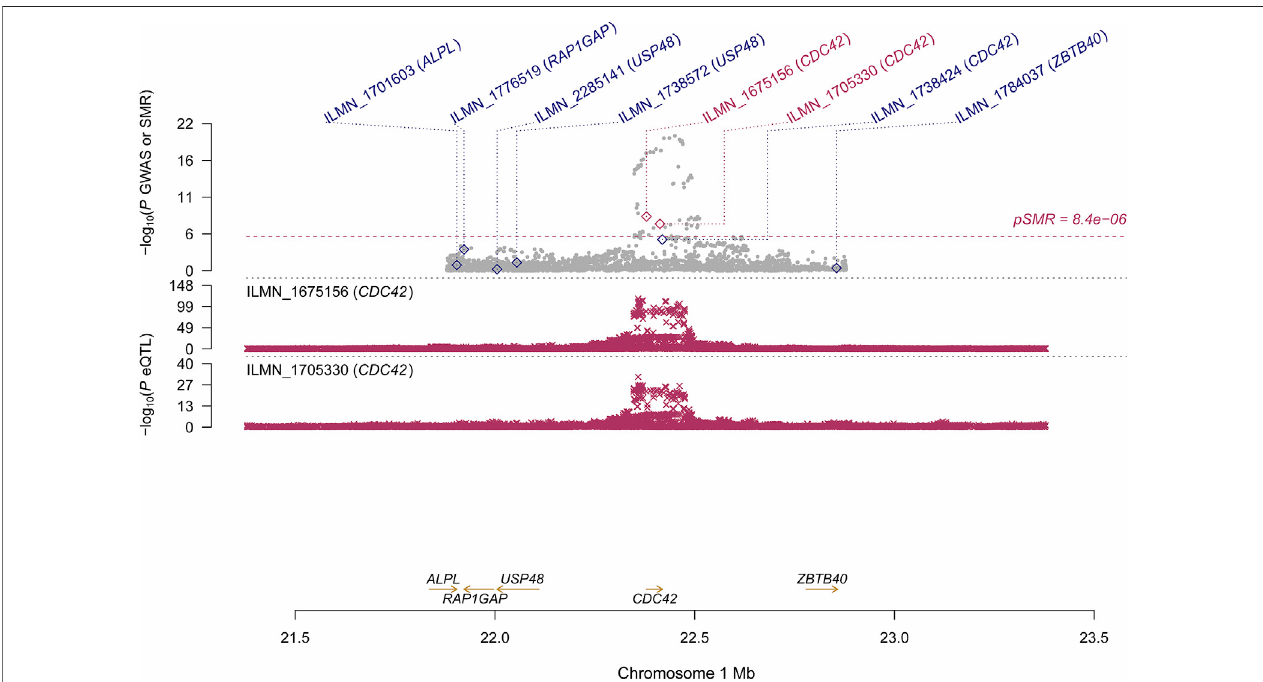
FIGURE2| Pleiotropicassociationof CDC42 withULsusingCAGEeQTL.Topplot,greydotsrepresentthe--log10( p values)forSNPsfromtheGWASofULs,with solid rhombuses indicating that the probes pass HEIDI test. Middle plot, eQTL results. Bottom plot, location of genes tagged by the probes. CAGE, Consortium for the Architecture of Gene Expression; eQTL, expression quantitative trait loci; GWAS, genome--wide association studies; GTEx, Genotype--Tissue Expression; HEIDI, heterogeneity in dependent instruments; SMR, summary data--based Mendelian randomization; SNP, single nucleotide polymorphism; ULs, uterine leiomyomas.